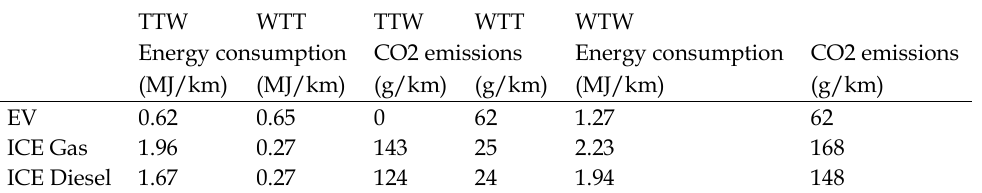
Table 14 WTW energy consumption (MJ/km) and CO2 emissions (g/km): comparison between technologies (Baptista et al,